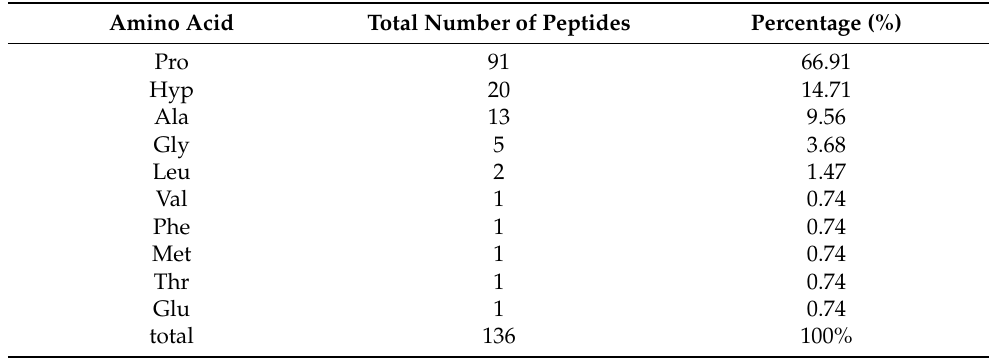
Table 6. Amino acids at P 2